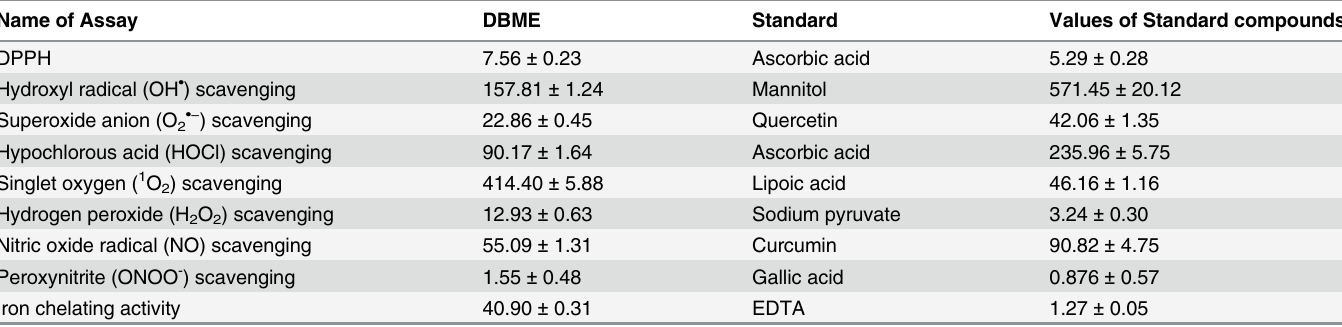
Table 1. IC 50 values of the DBME and standard compounds for DPPH, ROS and RNS scavenging and iron chelation assays. Name of